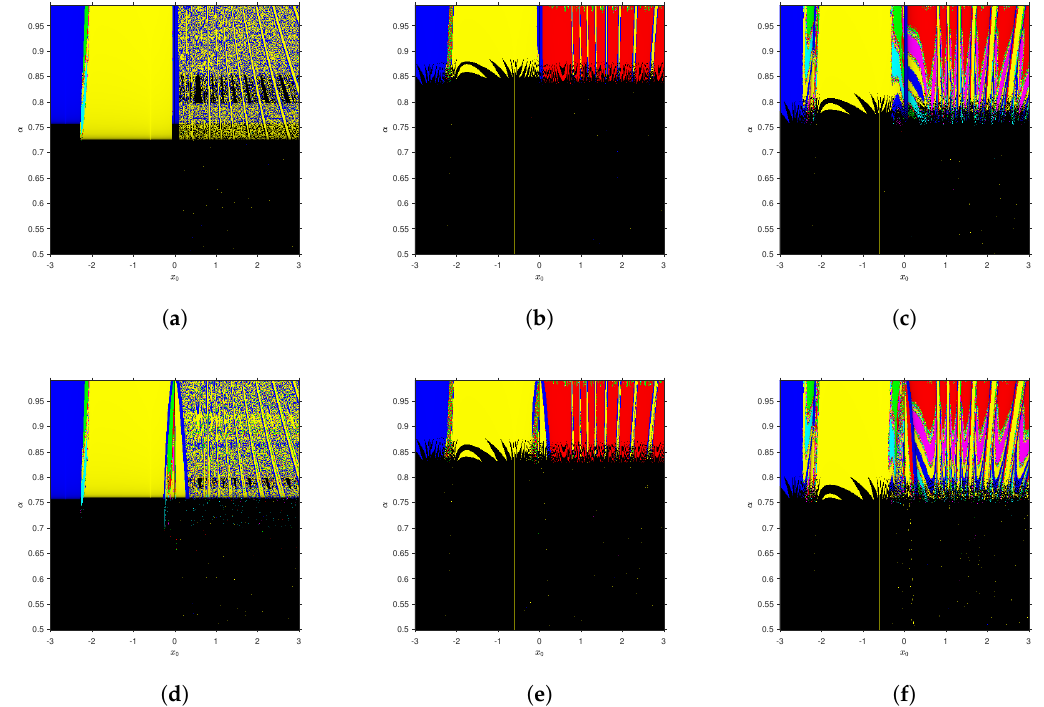
Figure 1. Convergence planes of fractional Newton and Traub-type methods on f 1 ( x ) with − 3 ≤ x 0 ≤ 3. ( a ) CFN 1 , 49.54% convergence; ( b ) CFN 2 , 27.15% convergence; ( c ) CFT, 41.5% convergence; ( d ) R-LFN 1 , 47.08% convergence; ( e ) R-LFN 2 , 28.85% convergence; ( f ) R-LFT, 44%